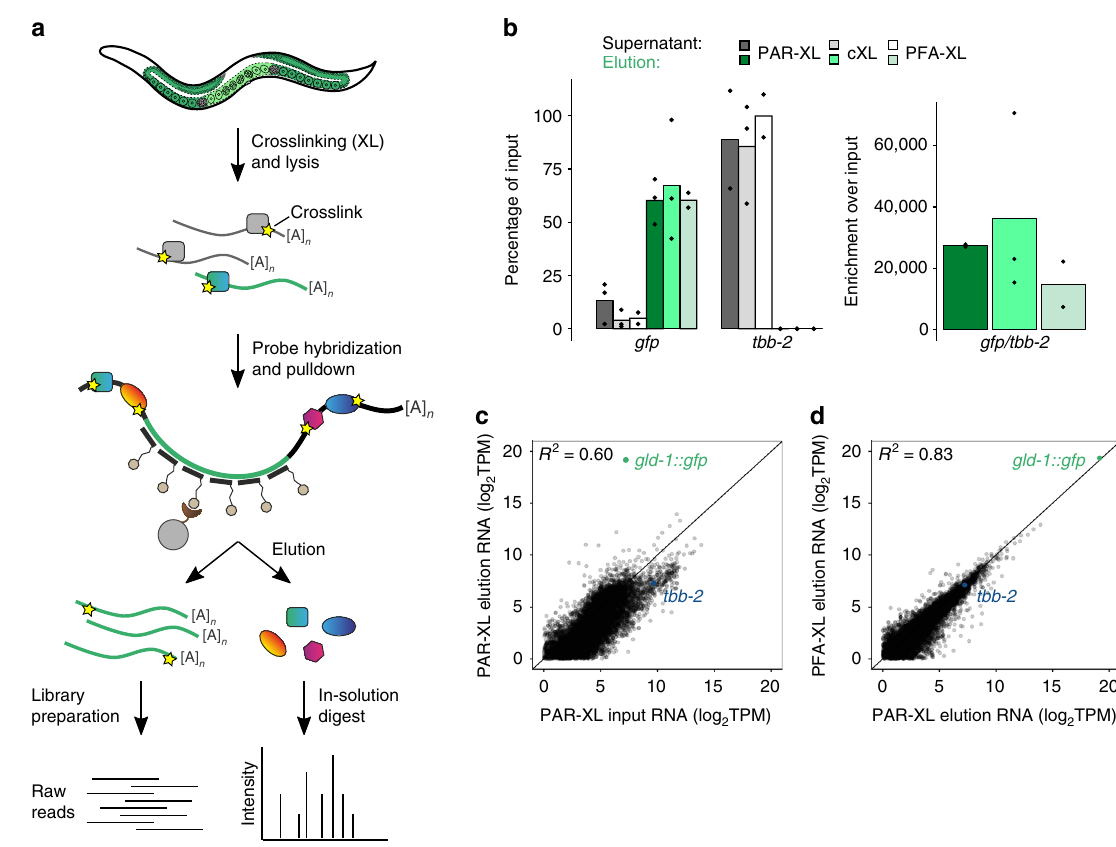
Fig. 1 vIPR, an in vivo RNA-protein crosslinking and pulldown approach, ef fi ciently and speci fi cally enriches for RNA of interest. a Synchronized C. elegans young adults were crosslinked either by UV irradiation (PAR-XL, cXL) or chemically via paraformaldehyde (PFA-XL). After lysis, biotinylated 20 nt long DNA probes (here: complementary to the gfp coding sequence (green)) were added to hybridize to the RNA of interest. The probe-target complexes were captured by streptavidin-coated magnetic beads. After selective elution of protein or RNA, samples were subjected to mass spectrometry (LC – MS/MS) for protein identi fi cation or RNA sequencing/RT-qPCR for relative RNA quanti fi cation. m / z : mass-to-charge ratio. b vIPR leads to ef fi cient and reproducible capture of the gld-1::gfp transcript, while tbb-2 , an mRNA control, is depleted from pulldown elutions. RNA levels were measured from n = 3 (PAR-XL), n = 3 (cXL), n = 2 (PFA-XL) independent pulldown experiments by RT-qPCR, bars represent means. c RNA sequencing of input and pulldown elution samples con fi rms, transcriptome-wide, the speci fi c enrichment of the gld-1::gfp transgenic RNA. Gene transcripts detected with a TPM count >1 in both samples are plotted. Input and elution samples are from independent PAR-XL pulldowns. Solid line represents diagonal. d RNA sequencing of pulldown elution samples employing either PAR-XL or PFA-XL shows reproducible RNA enrichment. Plotting analogous to c . PAR-XL, labeling of worms with 4- thiouridine (4SU) and crosslinking by UV 365 nm irradiation; cXL, crosslinking with UV 254 nm without prior labeling; PFA-XL, crosslinking